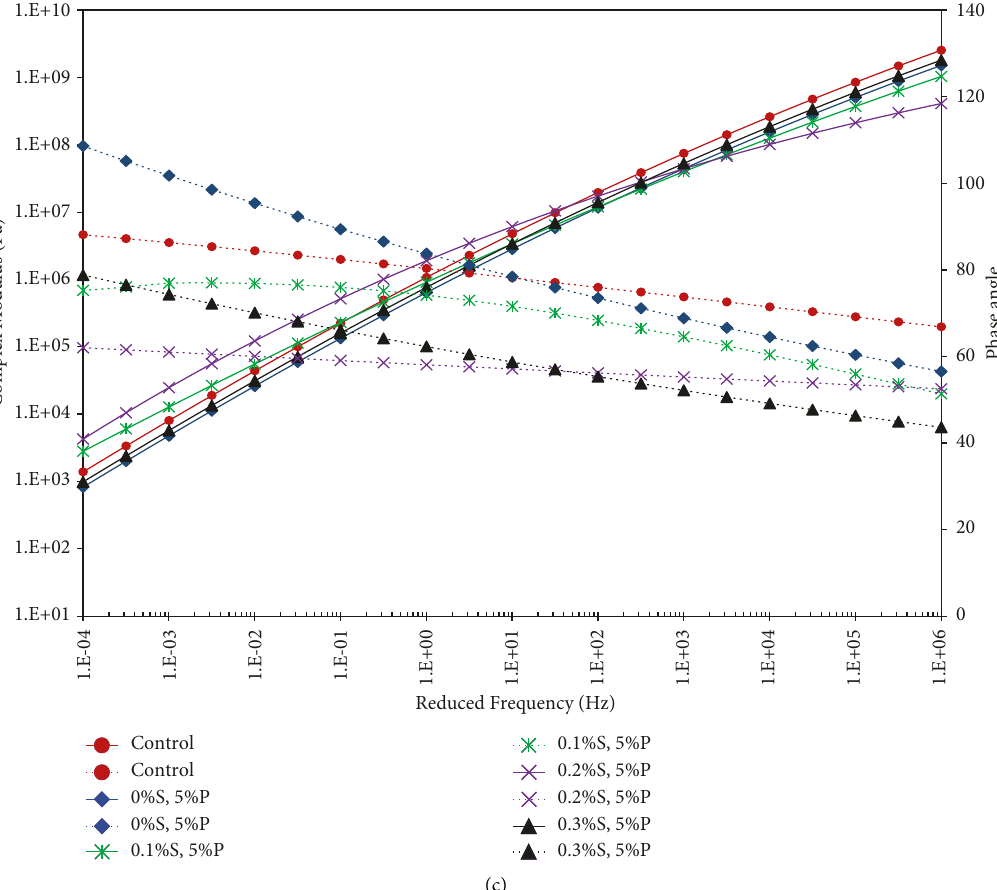
Figure 5: Complex modulus and phase angle master curves drawn on logarithmic scale at different sulfur content for polymer content of 3% P (a), 4%P (b), and 5%P (c) at reference temperature � 21.1 o